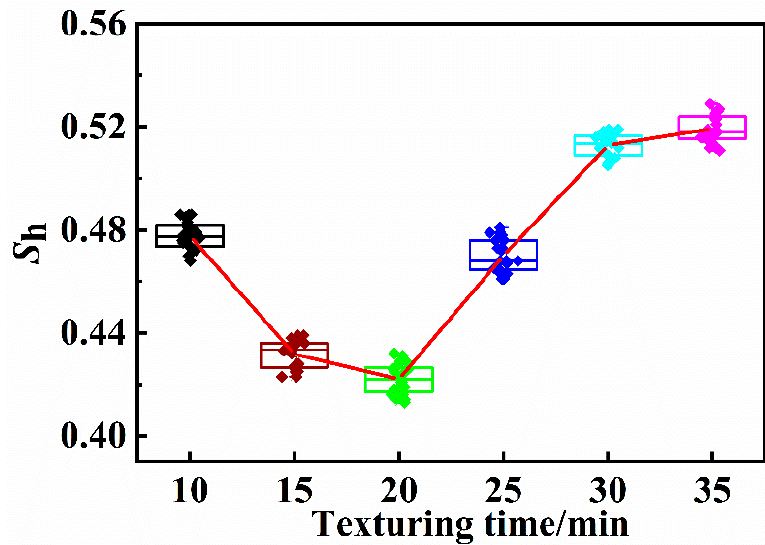
Figure 6. Relation between the relative standard deviation S h and texturing time.( the S h of the pyramidal texture on the surface of the wafers first decreases and then increases with increasing texturing time.)